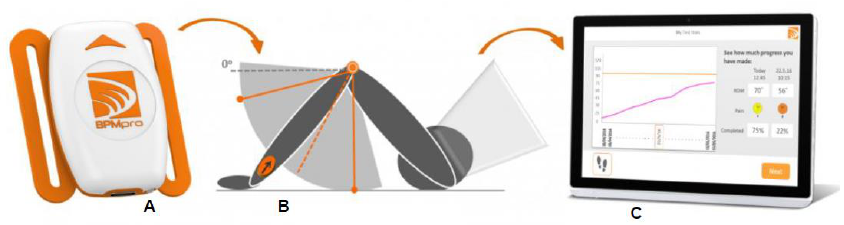
Figure 1. BPMPpathway sensor (A) that should be positioned above the malleolus lateralis (B) when the patient performs knee exercises. During the exercise the patients gets a live feedback on the actual performance over the patient application (C).